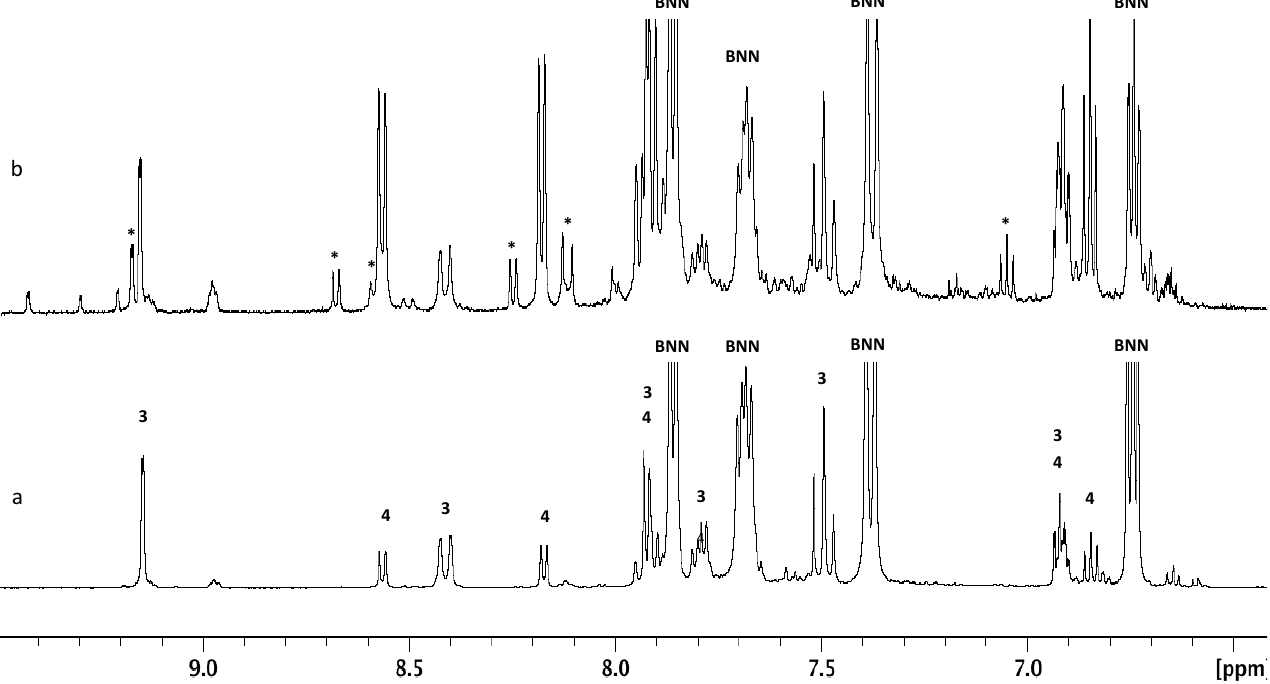
Figure 1. 1 HNMR analysis of the nitration mixture from the reaction of BNN with AcONO 2 and NO 2 BF 4 in CH 3 CN at 10–20 ◦ C. The products were measured in CD 2 Cl 2 . ( a ) AcONO 2 prepared from 1.0 equiv. of AgNO 3 and 1.1 equiv. of AcCl. ( b ) NO 2 BF 4 , 1.0 equivalent (dinitro-BNN ( 6 ) labeled as *).